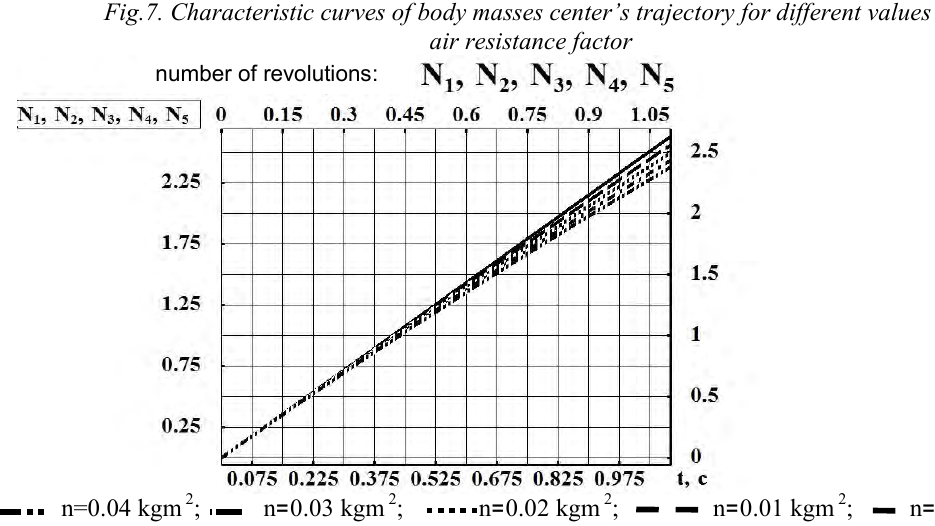
Fig.8. Characteristic curves of quantity of rotations for different values of air resistance